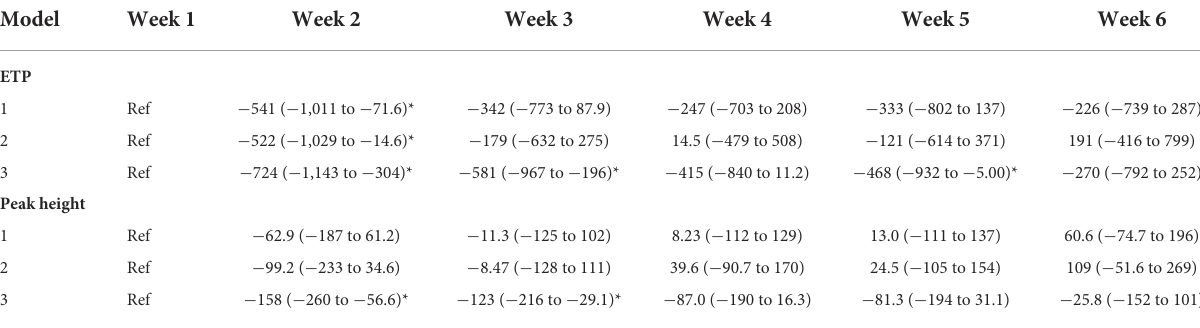
TABLE 3 Ellagic acid-induced thrombin generation parameters, differences over time. Model